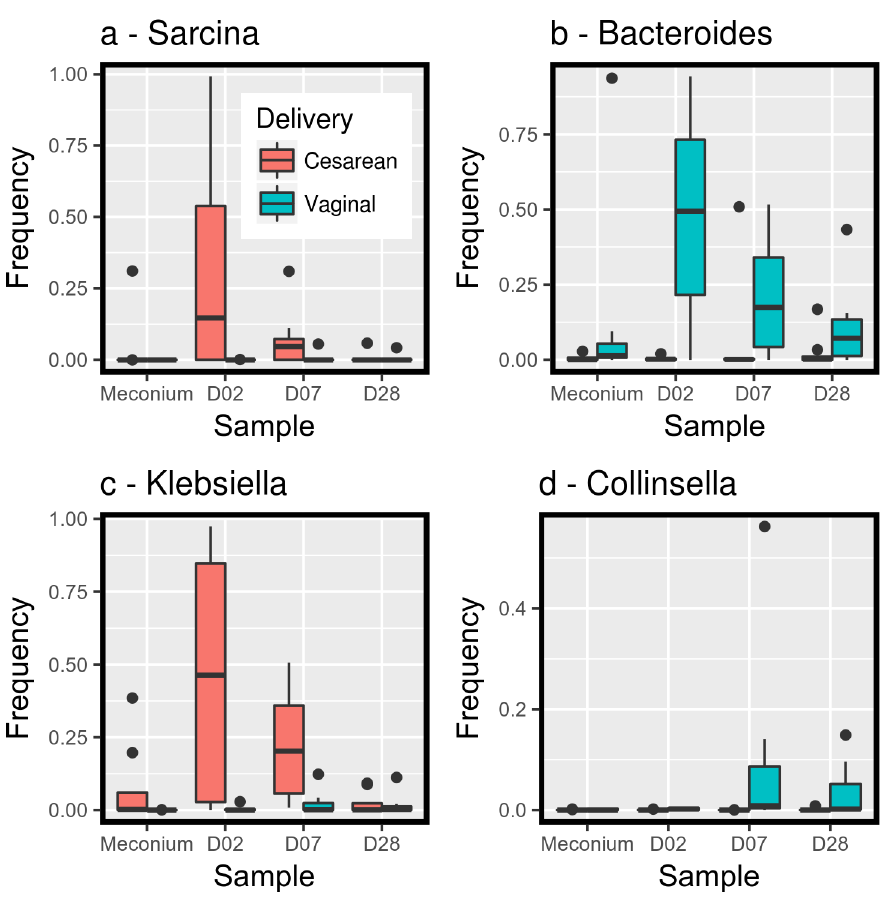
Fig 4. Relative abundance of four bacterial genera in the infants’ samples according to the sampling day and delivery mode (Cesareansections versus vaginal delivery). a: Sarcina b: Bacteroidetes c: Klebsiella d: Collinsella